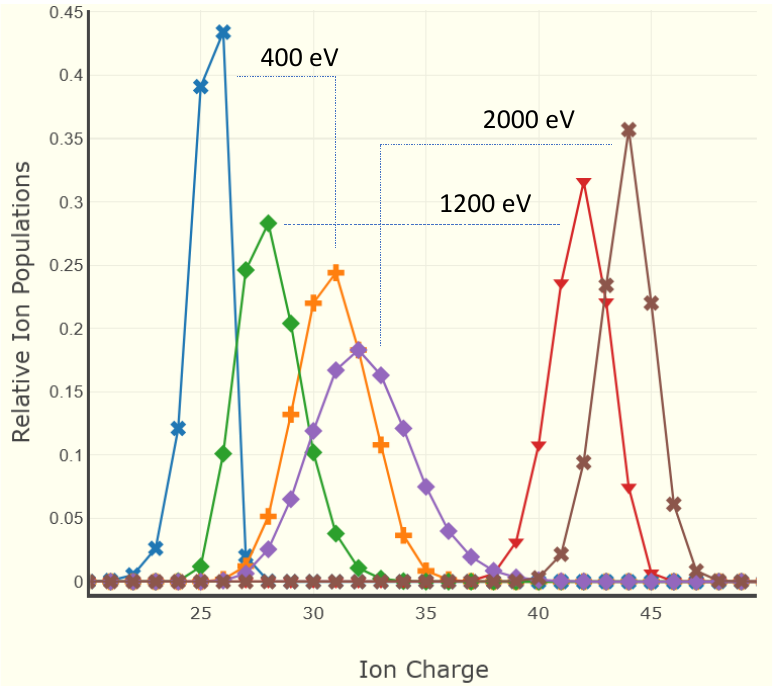
Figure 4. FLYCHK ionization distributions for a steady-state Xe plasma at electron temperatures 400, 1200, and 2000 eV, and electron densities 10 18 and 10 24 cm − 3 . The ionization curves for higher densities are shifted to the right due to enhanced ionization via excited